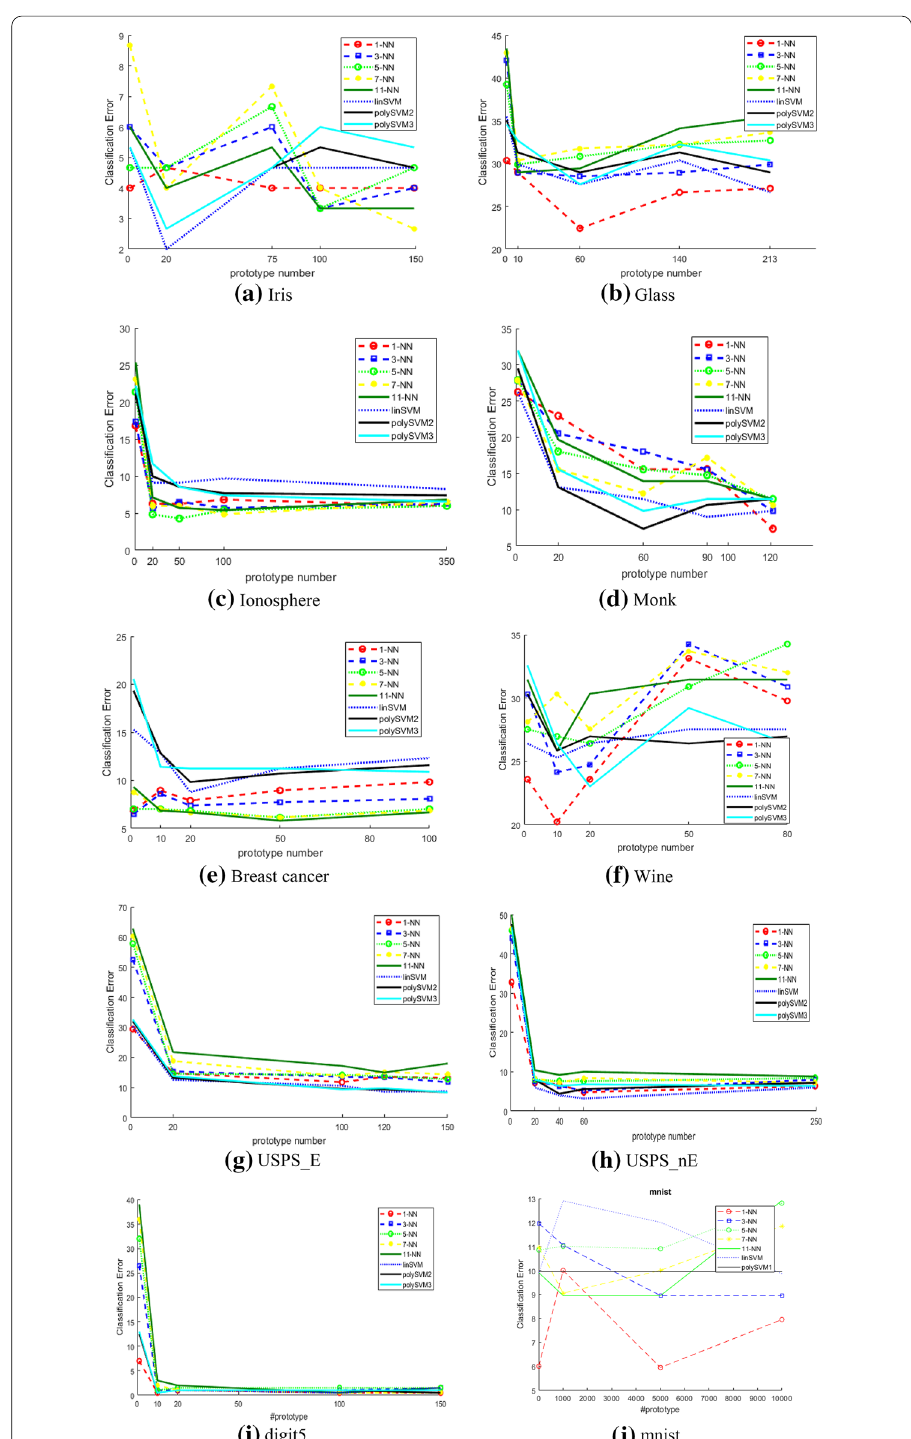
Fig. 5 Classification error of the proposed method versus the number of prototypes for the evaluation